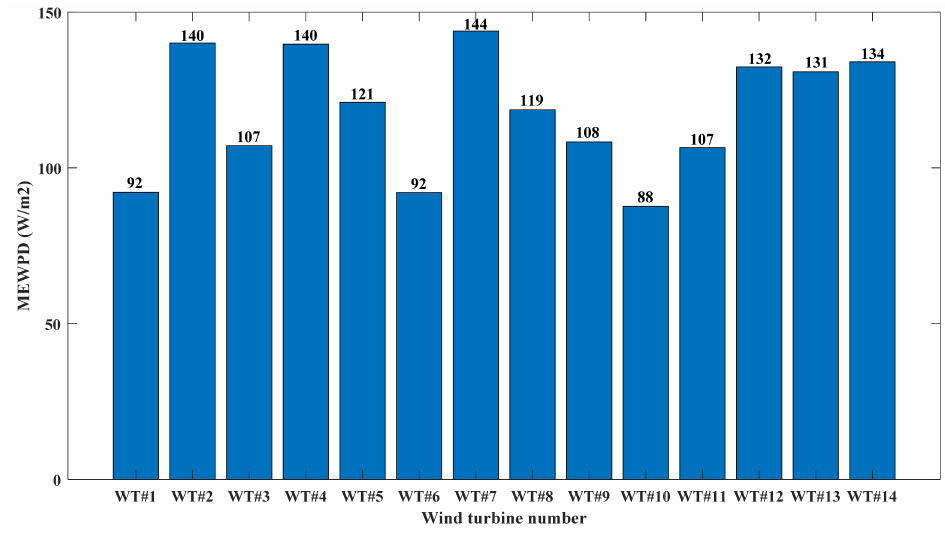
Figure 3. The calculation results of MEWPD of wind turbines.